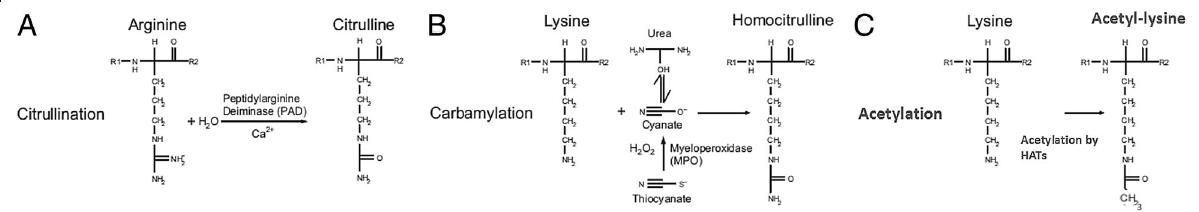
Fig. 2 Schematic illustration of post-translationally modified proteins: a Citrullination, ( b ) Carbamylation, and ( c )